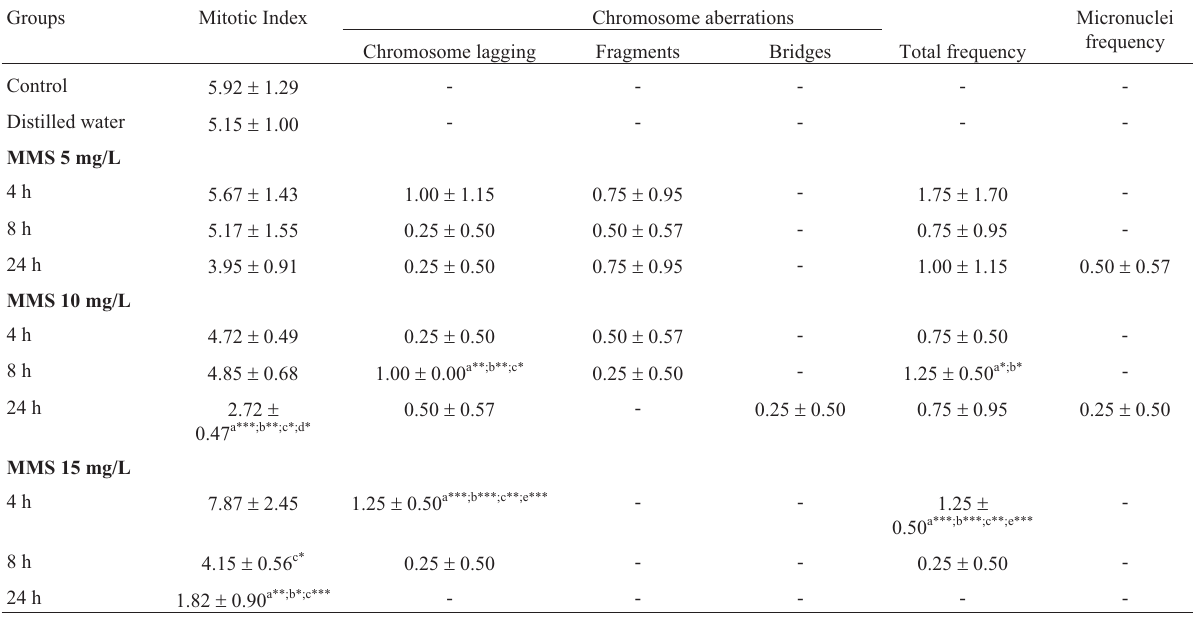
Table 3 - Mitotic index, frequency of chromosome aberrations and of micronuclei obtained in the cytogenetic tests on cells from the meristematic region (n = 4000) in roots of Phaseolus vulgaris L. accession GF004, exposed to methyl methanesulfonate (MMS).